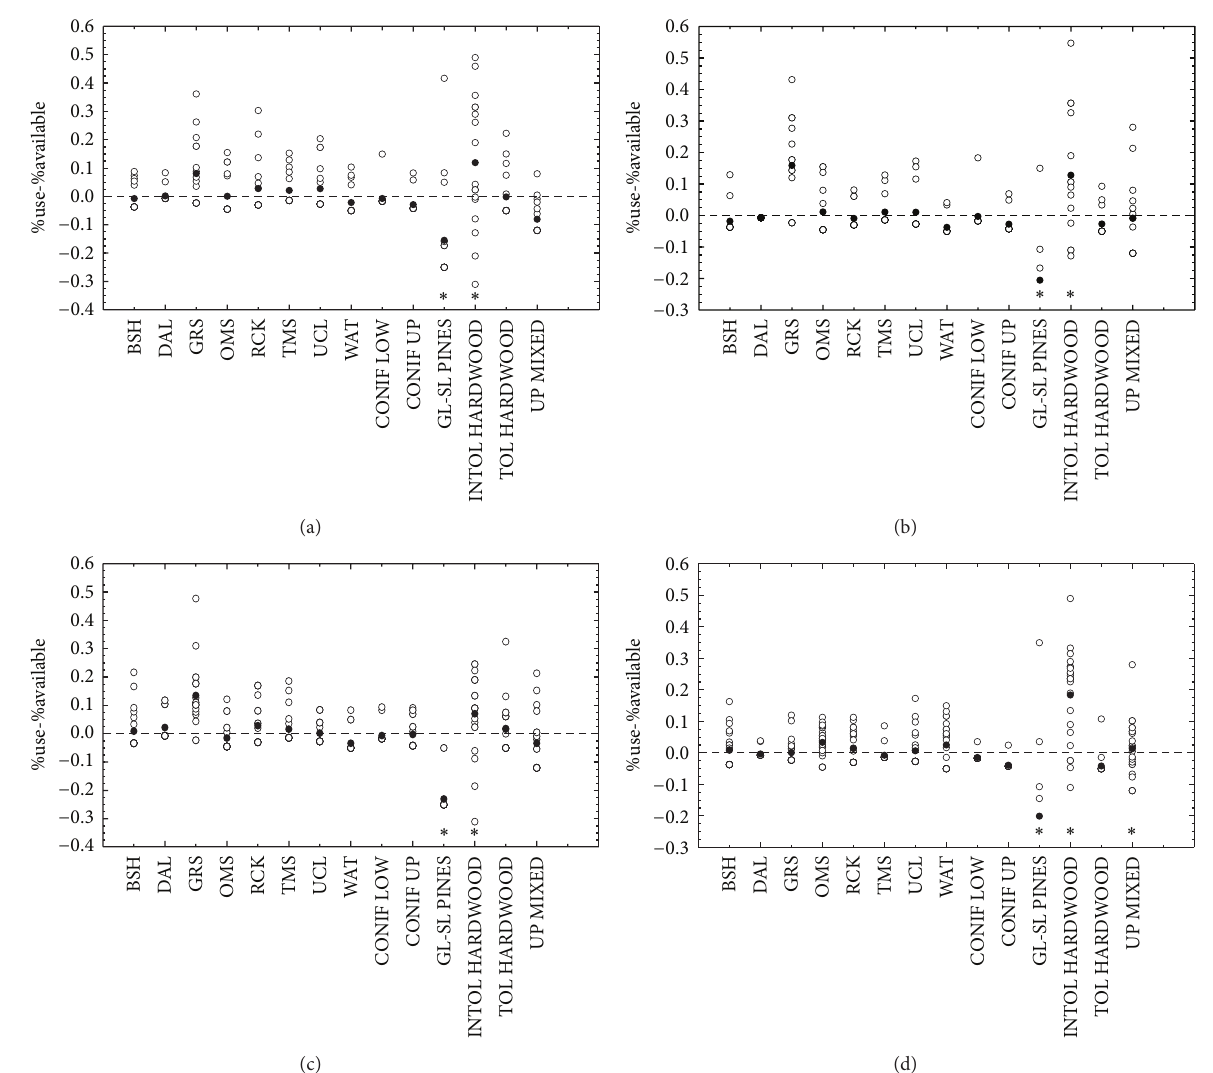
Figure 2: Comparison of % use by study elk to % availability for 14 habitat types during spring (a), summer (b), fall (c), and winter (d). Each hollow datum represents one animal; filled datum represents means. Means significantly different from zero are indicated by ∗ (𝑃 ≤ 0.01) Note: there may be overlap in data points due to grouping of